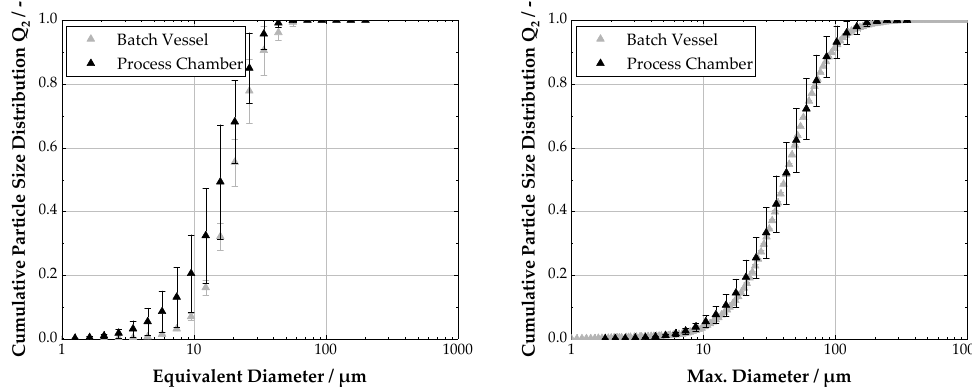
Figure 6. Particle size distribution as a function of the manufacturing route. It is found that both isometric ( left ) and rod-like ( right ) crystals with almost identical size properties as in the batch vessel may be produced in the process chamber. The data for the rods synthesized in the batch vessel are kindly provided by Dr.-Ing. Barros Groß and Prof. Dr.-Ing. Kind from the Institute of Thermal Process Engineering in Karlsruhe